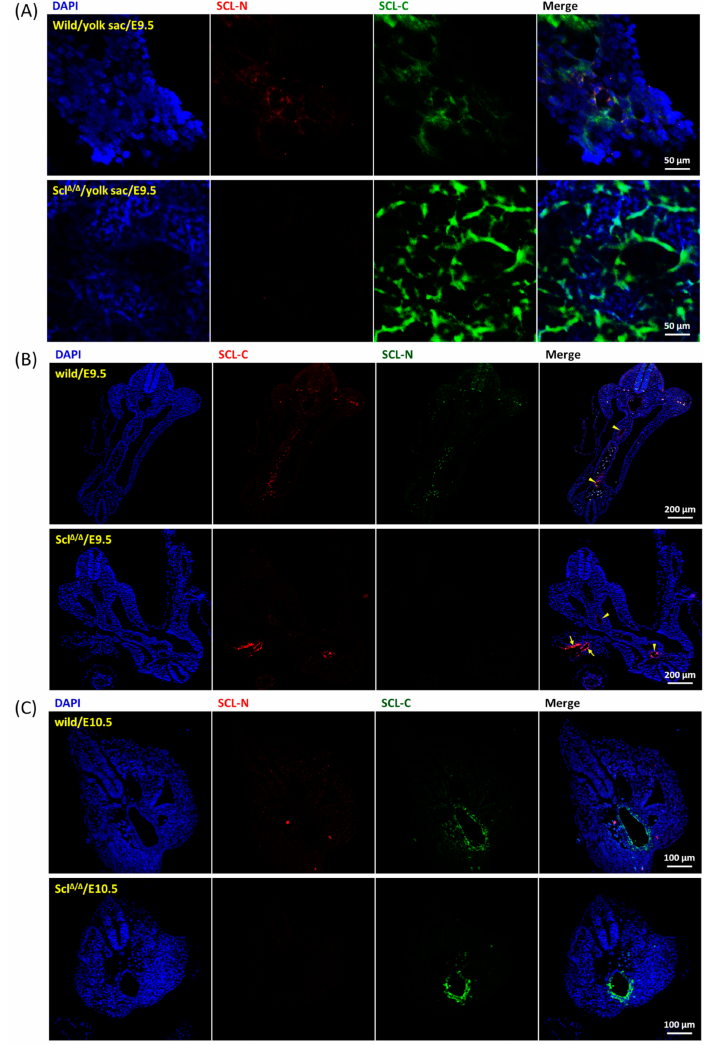
Figure 3. Expression patterns of SCL-C and SCL-L in wild-type and SCL deletion embryos. ( A ) A piece of E9.5 wild-type and SCL ∆ / ∆ yolk sac were labeled with SCL-N and SCL-C antibodies to uncover the cells expressing SCL-L and/or SCL-S. A fraction of the SCL-C positive cells was labeled by SCL-N antibody in the wild-type sample (upper panels), however, only, but much stronger, SCL-C signals were detected in the SCL ∆ / ∆ yolk sac (lower panels). ( B ) Transverse E9.5 embryonic sections including the aorta region were prepared and incubated with SCL-N and SCL-C antibodies. The endothelial layer of the wild-type section was stained by SCL-C alone, whilst overlapped SCL-C and SCL-N signals were observed on the dispersed cells inside the cavities of the trunk. Brighter SCL-C signals were found on the endothelial layer of the SCL ∆ / ∆ aorta. The aorta regions are indicated by arrow heads and the endothelial layer of extra embryonic vessels is indicated by arrows. ( C ) Transverse E10.5 embryonic sections including the aorta region were incubated with SCL-N and SCL-C antibodies. The endothelial layer of the wild-type section was stained by SCL-C alone, whilst a few dispersed cells inside the trunk cavities were doubly stained by SCL-C and SCL-N. Brighter SCL-C signals were found on the endothelial layer of the SCL ∆ / ∆